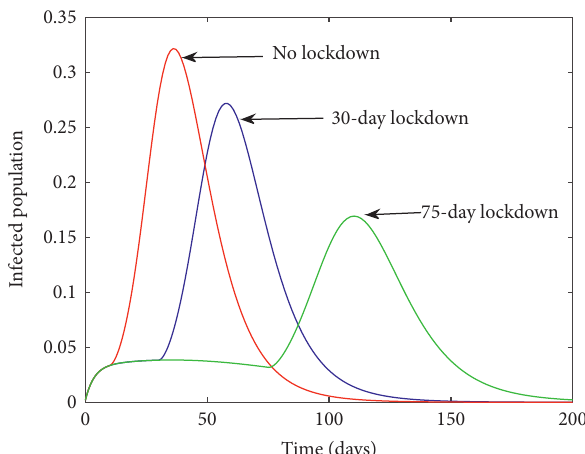
Figure 4: Dynamics of the infected population with and without lockdown over time